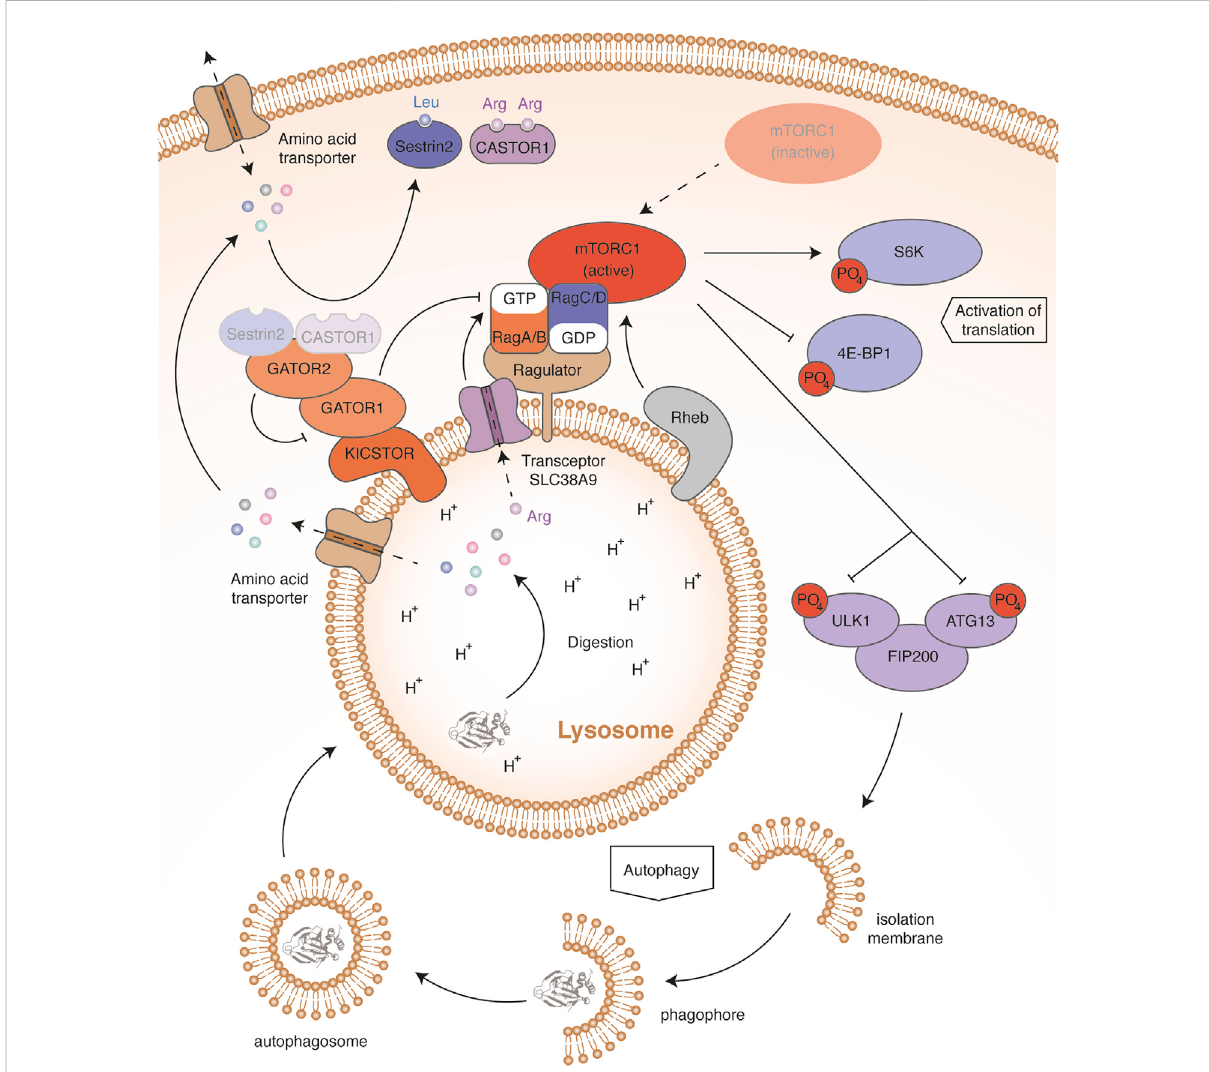
FIGURE 3 mTORC1 in amino acid regulation. In high amino acid conditions, Sestrin2 and CASTOR1 bind leucine and arginine, respectively. This induces their dissociation from GATOR2. Once released, GATOR2 inhibits by an unknown mechanism the activity of GATOR1, thereby preventing activation of the GTPase activity of RagA and RagB. In addition, high arginine levels sensed through the lysosomal transceptor SLC38A9 induce the release of GDP from RagA and RagB. High amino acid levels therefore maintain the binding of RagA and RagB to GTP. This allows Rags to recruit the mTORC1complextothelysosomalmembrane,therebyallowingactivation ofthemTORkinasebyRheb.ThemTORactivation contributestoamino acid storage and consumption by activating protein synthesis through the phosphorylation of S6K and 4E-BP1. mTOR activation also blocks autophagy by phosphorylating the ULK1-ATG13-FIP200 complex, stopping the recycling and release of amino acids. Conversely, in low amino acid conditions, the mTORC1 complex remains free and inactive in the cytosol. Absence of S6K and 4E-BP1 phosphorylation impairs protein synthesis, contributing to amino acid saving. Dephosphorylation of the ULK1-ATG13-FIP200 complex initiates autophagy and lysosomal protein degradation, releasing free amino